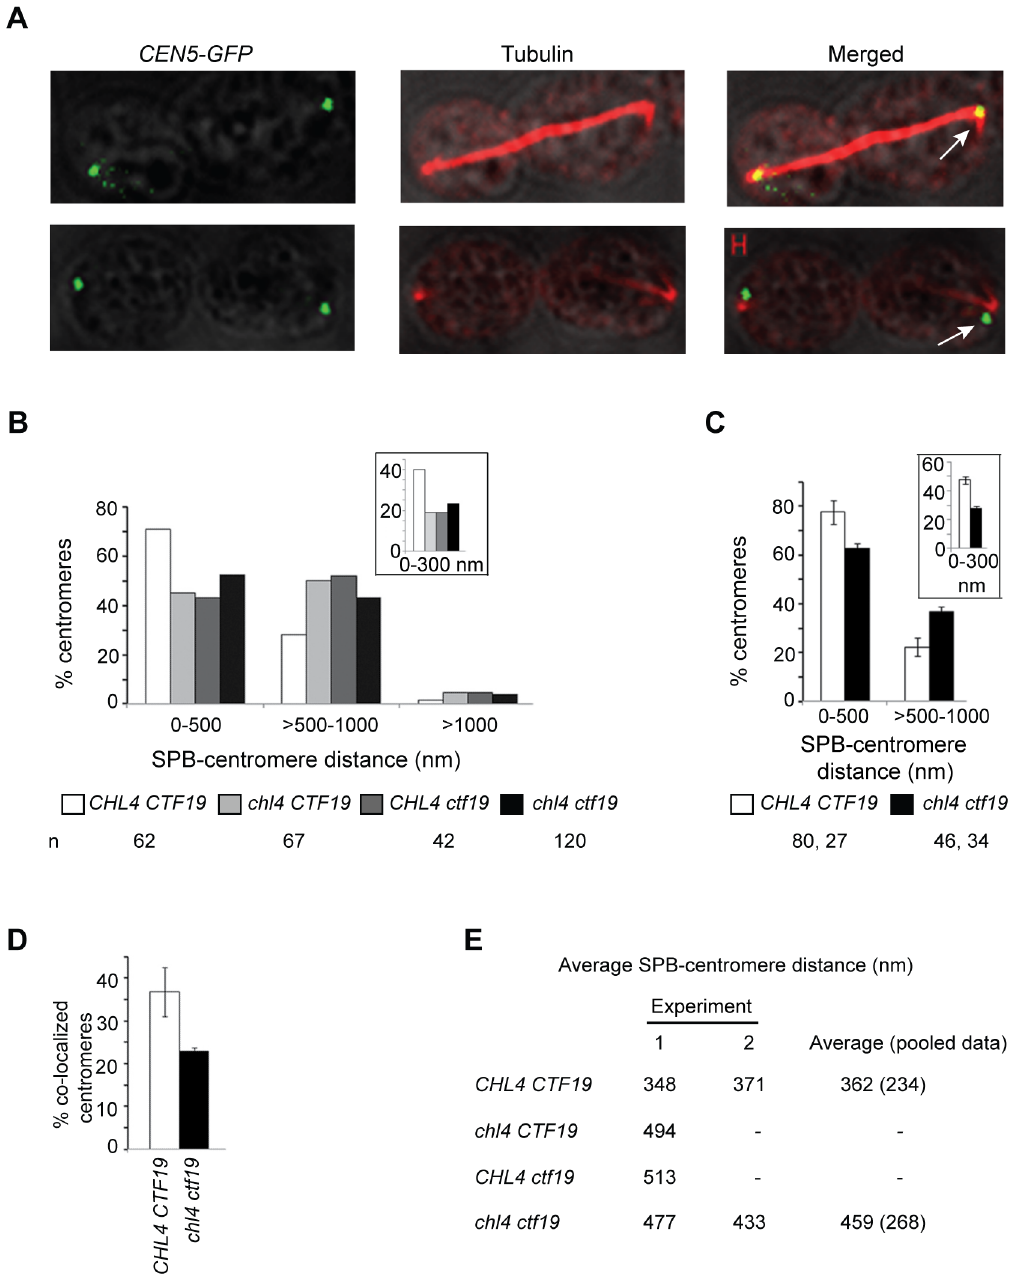
Figure 1. Average SPB-centromere distances are greater in mutant than in wild-type cells in late anaphase. US3329 ( CHL4 CTF19 ; wild- type), US3329 D chl4 ( chl4 ), US3329 D ctf19 ( ctf19 ) and US3329 D ctf19Dchl4 ( chl4 ctf19 ) cells, each carrying CEN5 - GFP tag, were grown to log phase in YEPD medium at 30 u C and then arrested at G2/M using nocodazole (15 m g/ml) for 90 minutes. Cells were fixed with formaldehyde after 30 minutes of release from G2/M, to maximize the population of anaphase cells. MTs and spindle pole bodies (SPB) were stained with anti- a -tubulin antibody, YOL1/34. Images were captured and analyzed by confocal microscopy. (A) Large budded cells having anaphase B spindles showing colocalization (upper panel) and non-colocalization (lower panel) of CEN5 (green dot) with SPB (bright red spot at the end of the spindle, from where astral and nuclear MTs emanated). Arrows in merged panels indicate CEN5 -SPB colocalization (upper panel) and non colocalization (lower panel). Scale bar, 0.5 m m. (B and C) 3D distances from the center of CEN5 - GFP dot to the center of spindle pole were measured in cells having long anaphase spindles. Images were taken at 0.5 m m z-sections for (B) and at 0.2 m m z-sections for (C). For (C), two independent experiments were performed with wild-type and chl4 ctf19 strains and the data represents averages obtained from these experiments, error bars indicating deviations from the average. For both B and C, ‘n’ refers to the number of centromeres analyzed and insets show % centromeres within 0–300 nm from their SPBs. (D) Histogram depicts percentages of colocalized CEN5 and spindle pole obtained from (C). The bars are the deviations from mean values. (E) The average distances between centromere and SPB in wild-type and mutant cells, obtained from B (Experiment 1) and C (Experiment 2; pooled from two experiments) are summarized. Next column displays the average of Experiments 1 and 2. Standard deviations from average values are in parenthesis. ‘-‘ indicates not done.